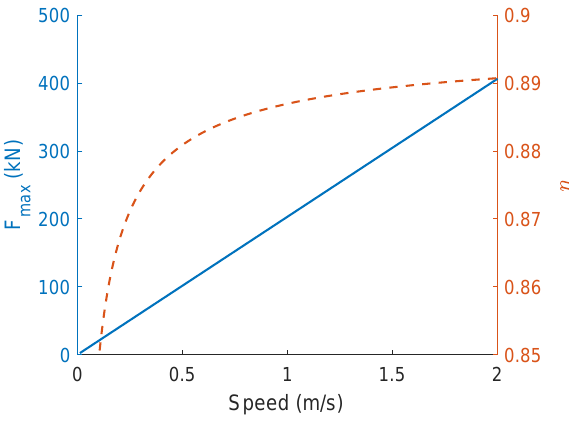
Figure 9. Maximum damping force and efficiency for different speeds for the original generator design operated with CTA control. The efficiency is here shown for a generator run with the damping force increasing linearly with increasing